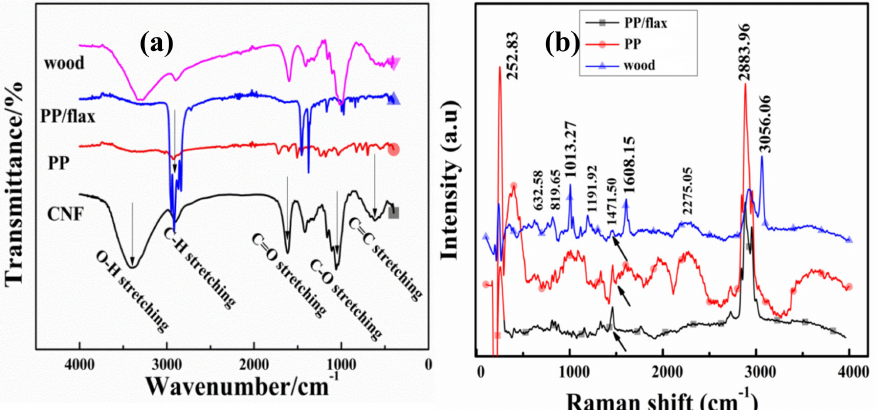
Figure 4. ( a ) FTIR and complementary and ( b ) Raman analysis for each